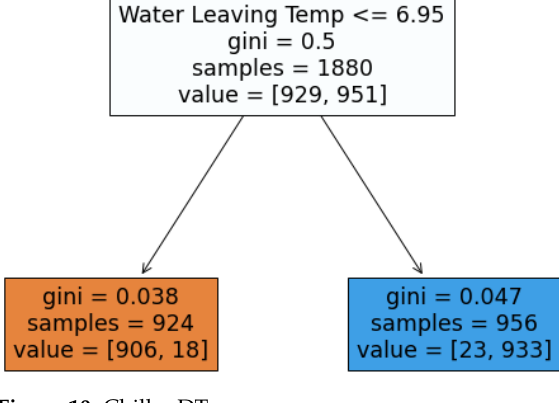
Figure 10. Chiller DT.